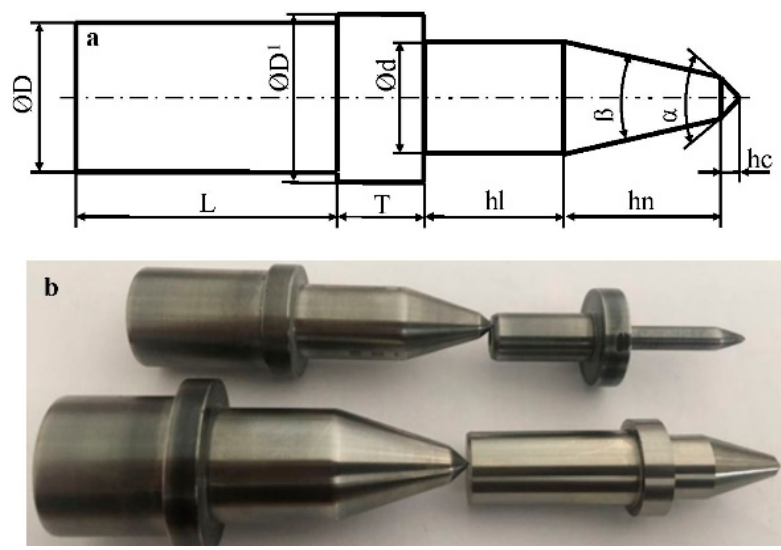
Figure 2. Conical tools: ( a ) geometrical dimensions of tools ( b ) photos of tools.